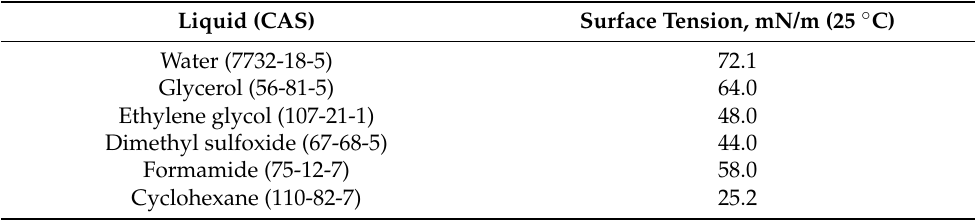
Table 1. Surface tension of probe